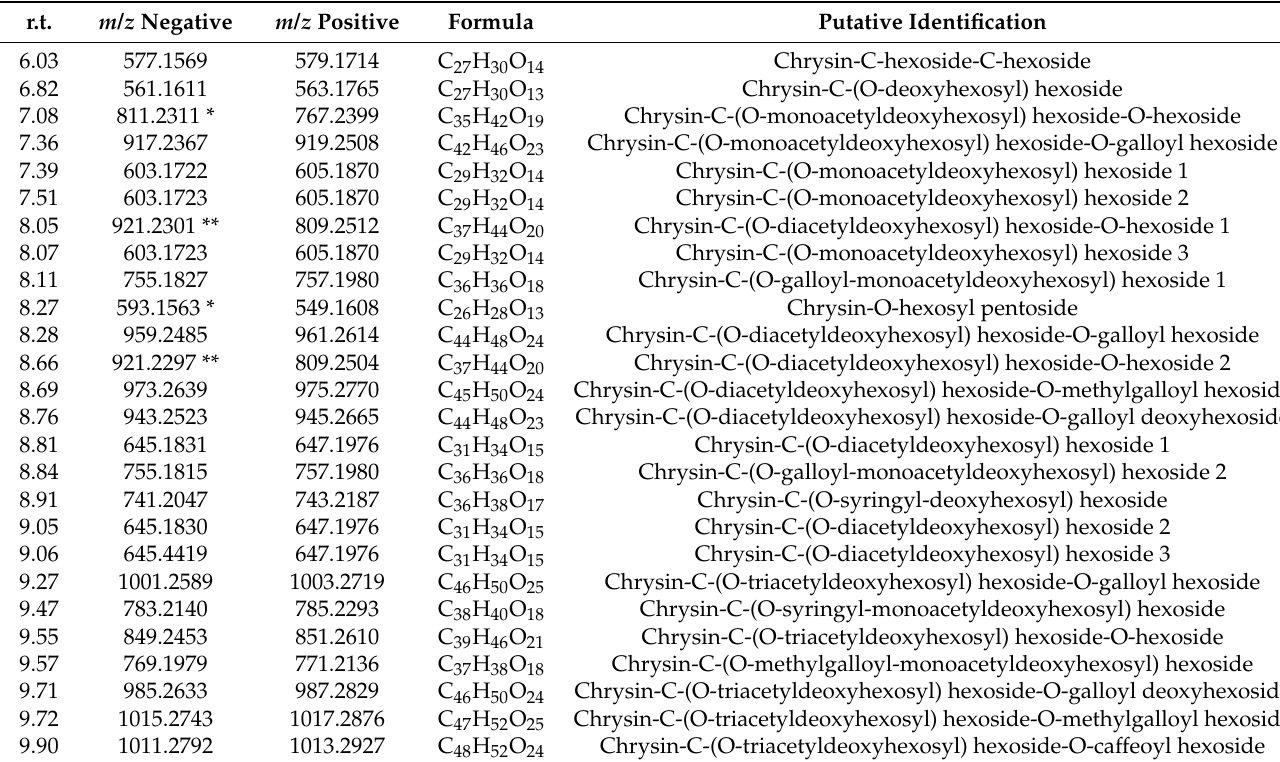
Table 1. Chrysin derivatives putatively identified in Oncidium sotoanum organs.